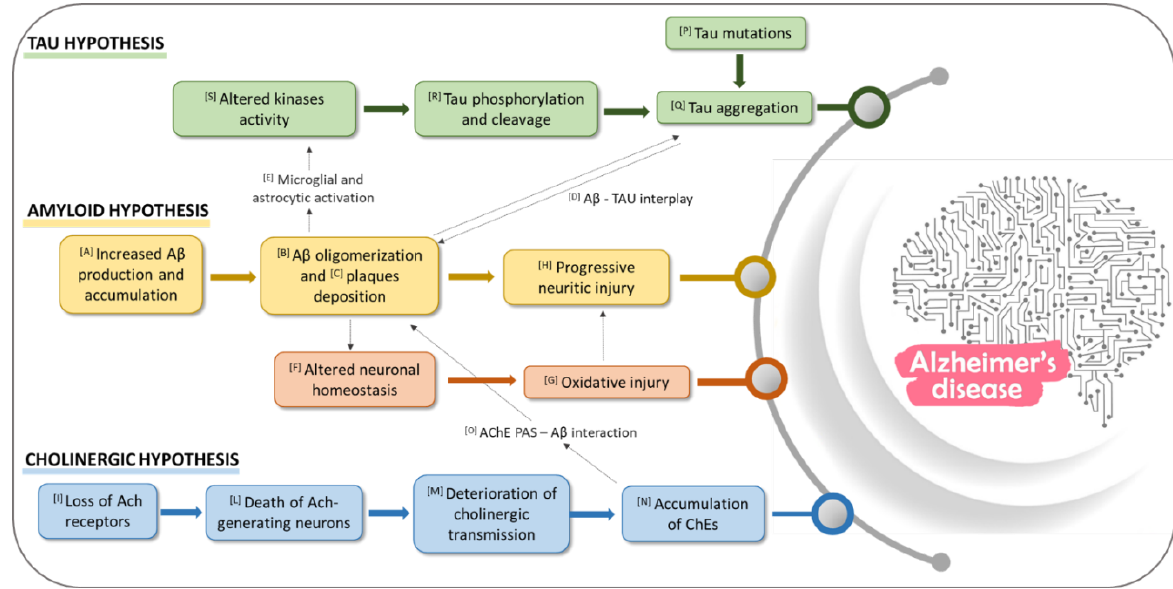
Figure 1. Schematic representation of some biochemical pathways implicated in AD pathogenesis: the interconnection between main targets of NQ and AQ derivatives. Each letter refers to a key event that signs AD etiology, as detailed in the following paragraphs (Sections 1.1–1.3).